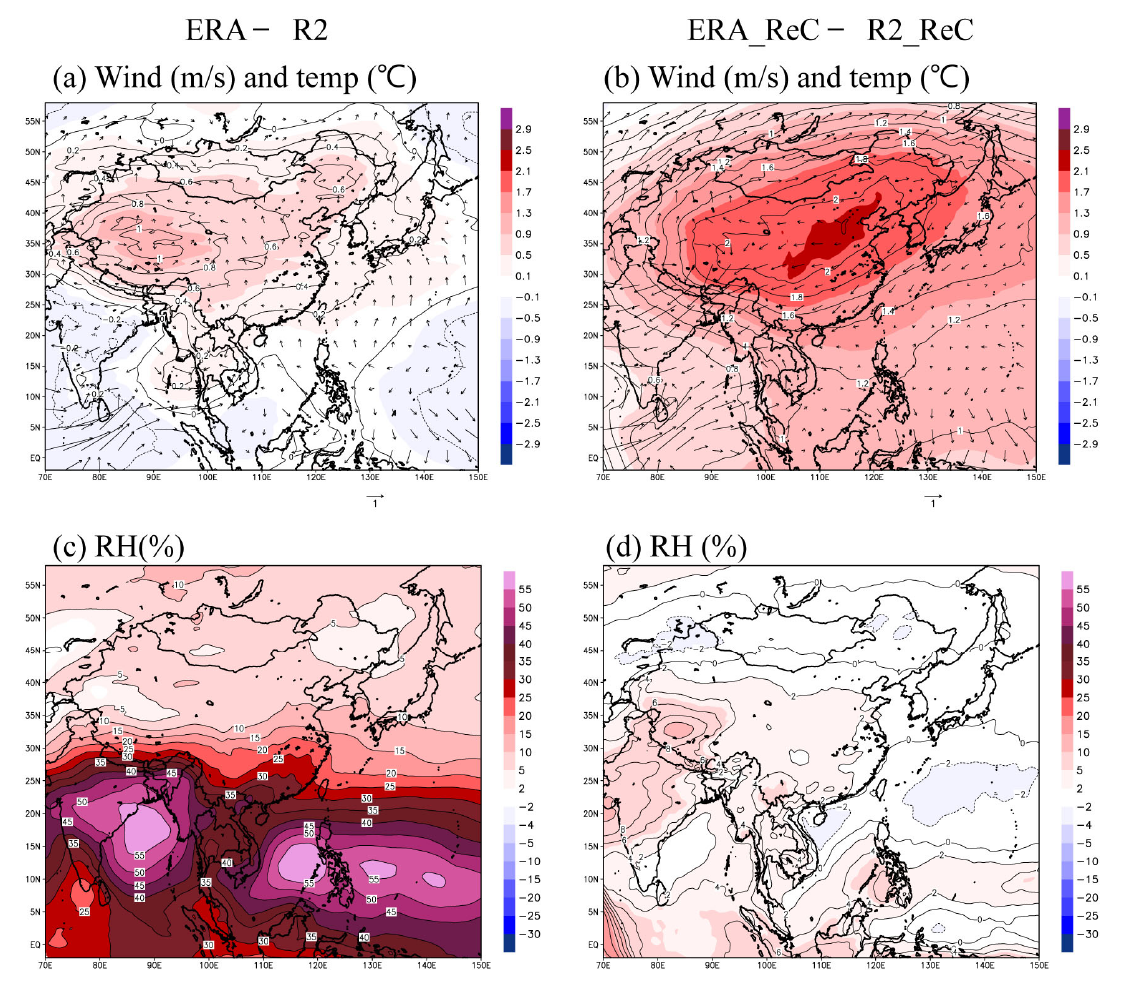
Figure 4. Spatial distribution of 20-year winter mean differences for ( a , b ) wind field (m/s) and temperature (°C); ( c , d ) relative humidity (RH, %); and ( e , f ) mixing ratio (Q, g/kg) at 850 hPa between the two BCs (ERA, R2) ( left ) and between the two simulations (ERA_ReC, R2_ReC) forced by the ERA and R2 datasets ( right